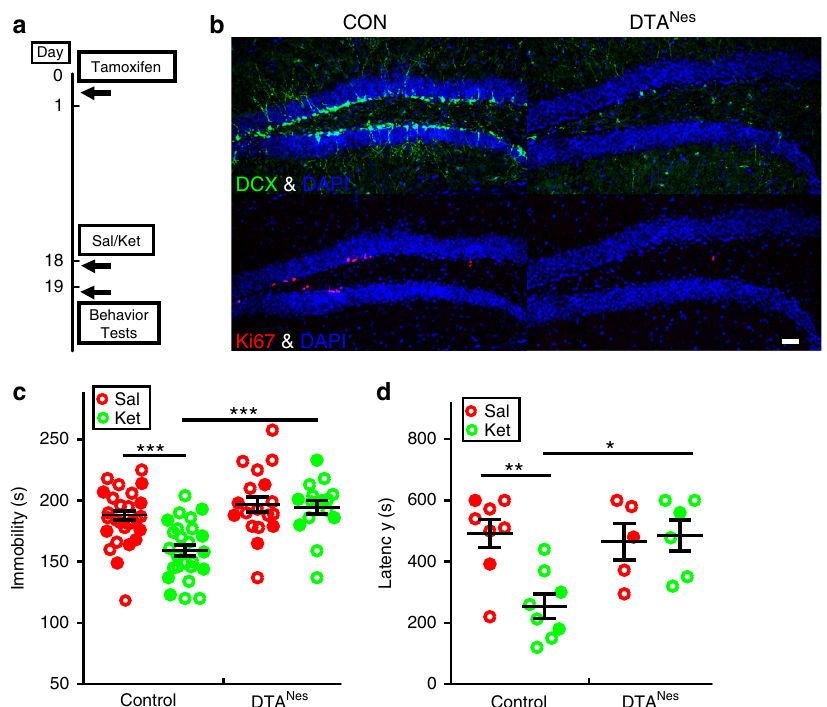
Fig. 3 DTA mediated ablation of DCX + cell population abolishes the ketamine antidepressant effect. a Nestin-creER T2 ; Rosa26-DTA (DTA Nes ) heterozygote mice were given tamoxifen 18 days before Saline (Sal) or Ketamine (Ket) treatment and were exposed to behavior tests 24 h afterward. b Representative confocal images show the ef fi cient elimination of adult neural stem/progenitor cells, as measured by DCX (green) and Ki67 (red). Scale bar, 50 µ m. c In the forced swim test (FST), the signi fi cant decrease of immobility time induced by ketamine treatment is fully blocked in DTA Nes mice (2- way ANOVA with unweighted mean analysis, Tukey post hoc,*** p = 2.063E − 5 for ketamine vs. saline-treated control mice and *** p = 5.471E-6 ketamine- treated control mice vs. DTA Nes mice). d DTA Nes mice treated with ketamine do not display a reduction in latency to feed in the novelty-suppressed feeding test (NSFT; two-way ANOVA, Tukey post hoc ** p = 0.0041 for saline vs. ketamine-treated control animal; * p = 0.0105 for ketamine-treated control mice vs. DTA Nes mice). Circles in solid color denote female mouse data